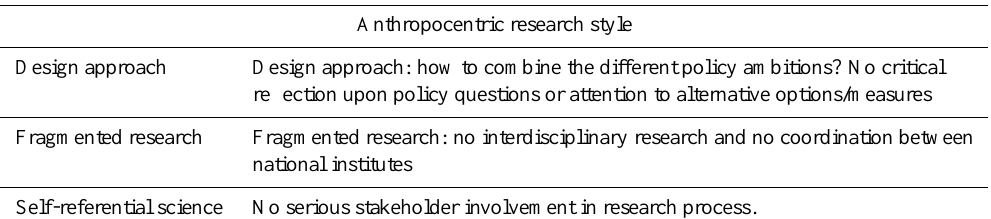
Table 8. Research style